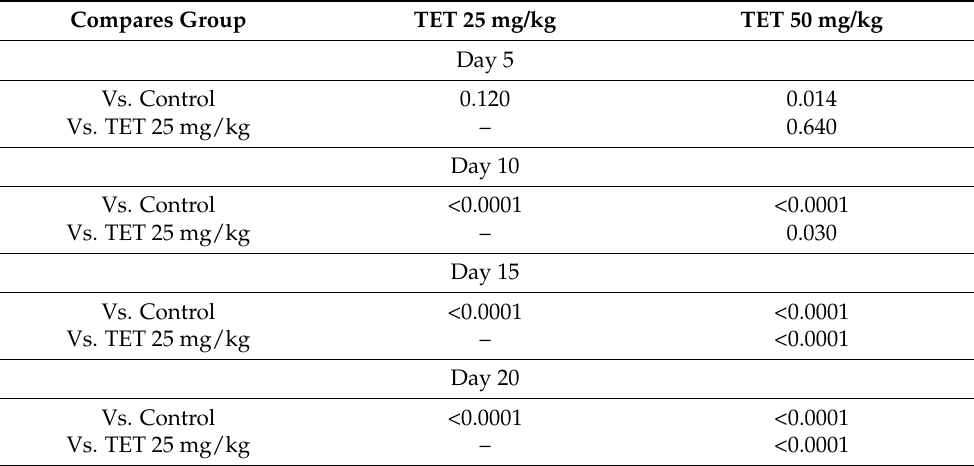
Table 1. The accurate p -value in Figure 3A is displayed. Here we summarized the p -value between control and two treatment groups of tumor volume.